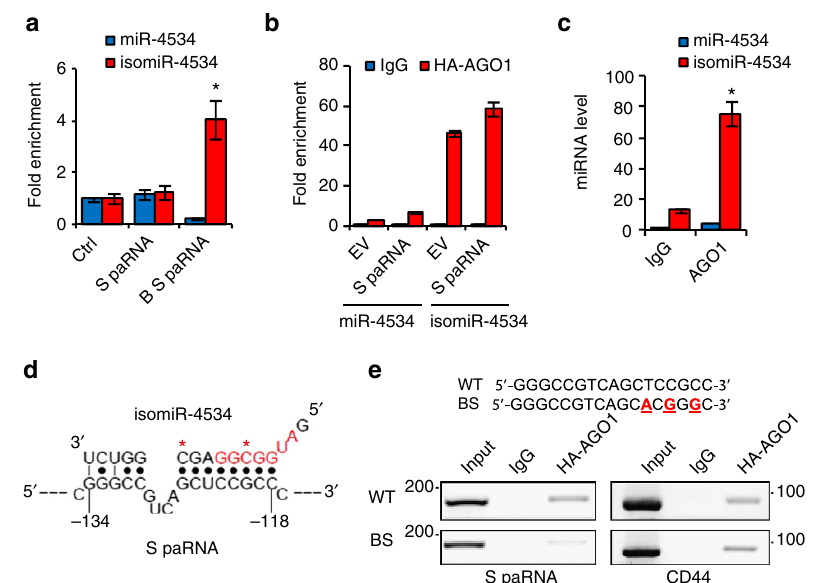
Figure 5 | IsomiR-4534 guides Argonaute 1 binding to sense promoter-associated RNA. ( a ) Binding of isomiR-4534 to HA-AGO1 and biotinylated S-paRNA (B S-paRNA) in RNA pull-down. S-paRNA, nonbiotinylated S-paRNA; Ctrl, control RNA. ( b ) IsomiR-4534 binding to HA-AGO1 in cells transfected with empty (EV) or S-paRNA expression vector determined by RIP. ( c ) IsomiR-4534 binding to chromatin-associated AGO1 determined by RNA-ChIP. ( d ) Predicted base pairing of isomiR-4534 with S-paRNA. Asterisks, edited bases in isomiR-4534; Red bases, nucleotides in putative canonical seed region. ( e ) Binding of AGO1 to S-paRNA with either wild-type (WT) or mutated isomiR-4534 binding sequence (BS) determined by RIP. CD44 mRNA, positive control. Top, red underlined bases indicate mutated bases in the BS construct. Data are mean ± s.d. of three independent determinations. Student’s t -test was used for P value assessment. * P o